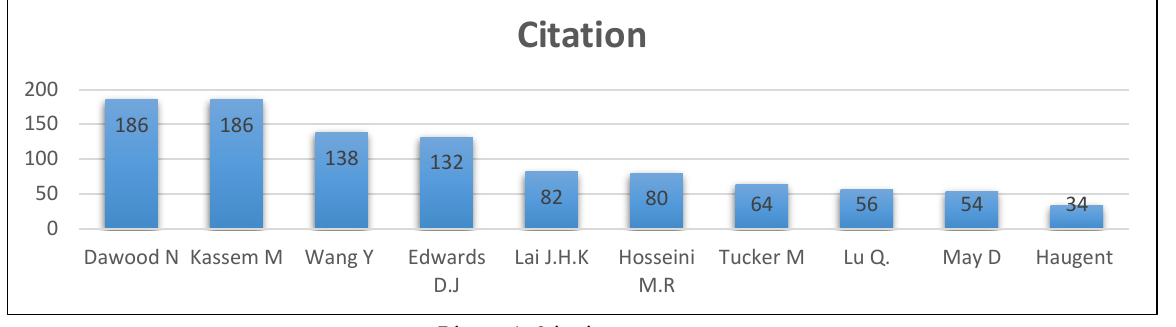
Figure 4: Citation per source.